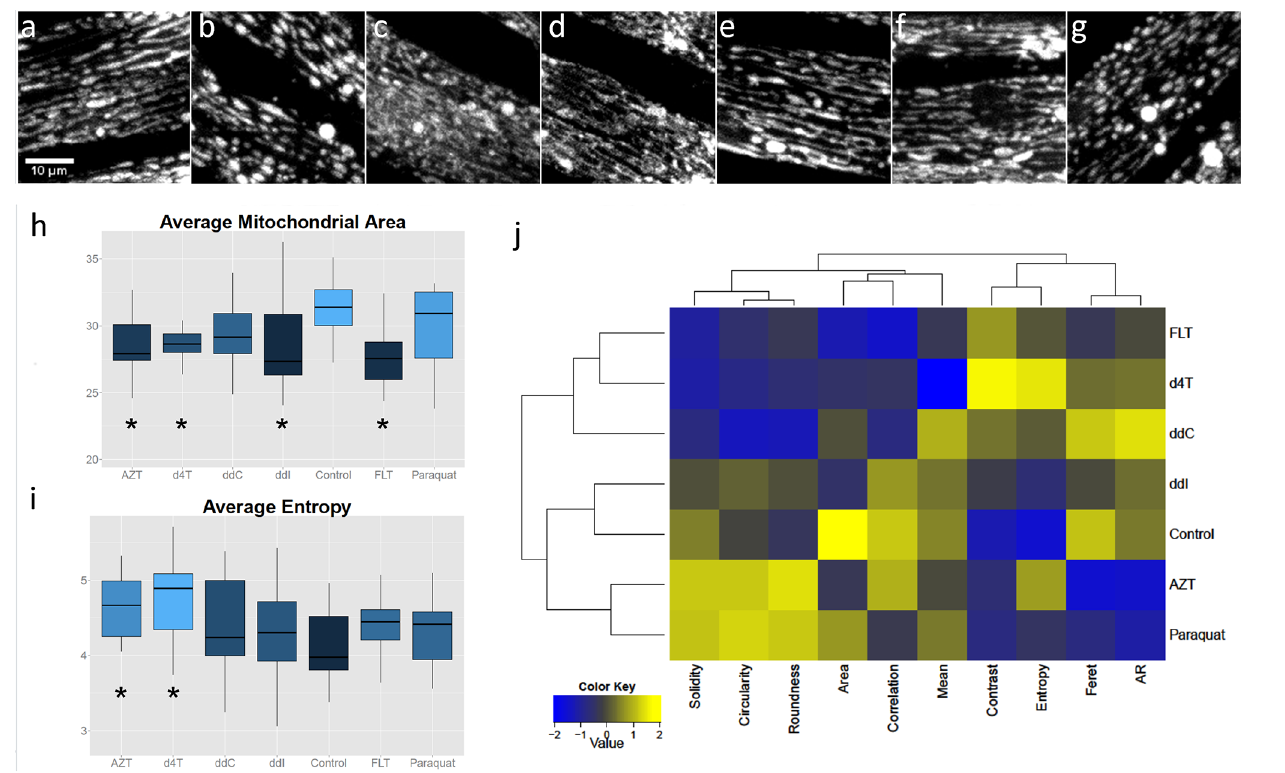
Fig 5. Exposure to NRTIs causes changes in mitochondrial morphology. a-g: Mitochondrial morphology in the body wall muscle of worms exposed to NRTIs (200 μ M) (a: control, b: AZT, c: FLT, d: d4T, e: ddI, f: ddC) and g: Paraquat.) (h,i): Boxplots comparing selected metrics per condition. Asterisks indicate statistically different from control (per metric). (j): Two-dimensional clustergram performed on the standardized dataset (z-scores) of features extracted after image analysis, using Euclidean distance as distance metric and the average value as linkage value for the dendrograms